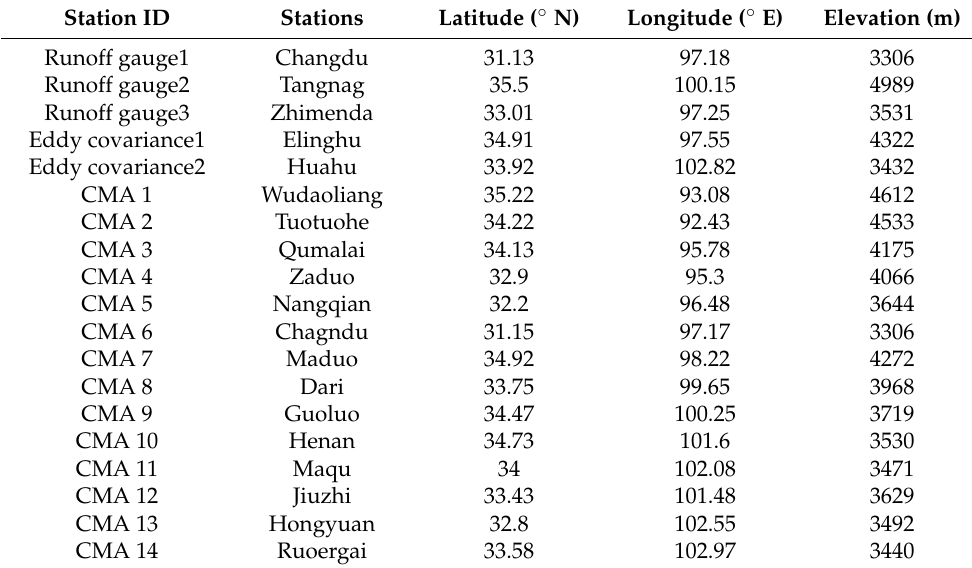
Table 2. The coordinates of hydrographic stations (red pentagons in Figure 1), turbulent heat flux stations (pink pentagrams in Figure 1), and China Meteorological Administration ground observation (CMA) stations (black triangles in Figure 1). Station ID Stations Latitude ( ◦